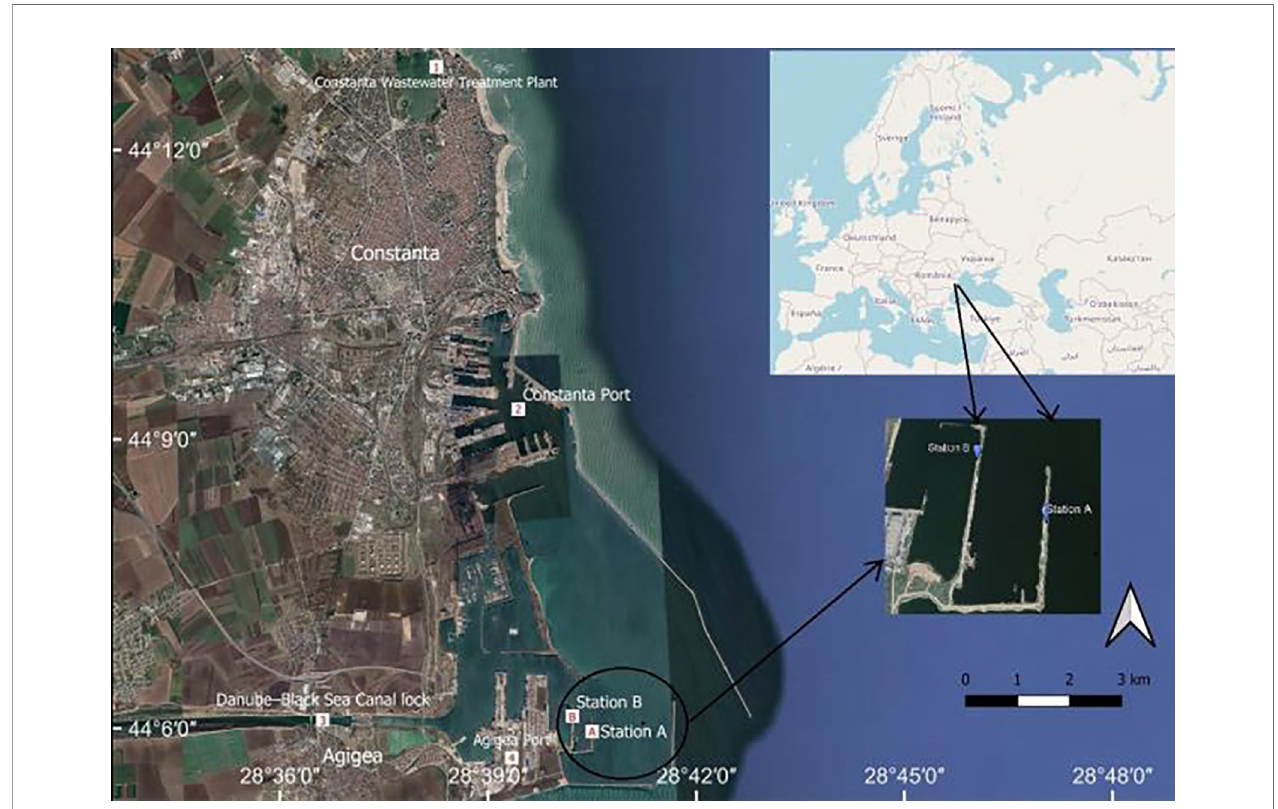
FIGURE 1 | Constanta Sud − Agigea Port area map (Google Earth Pro 7.3.4.8248, 2021;